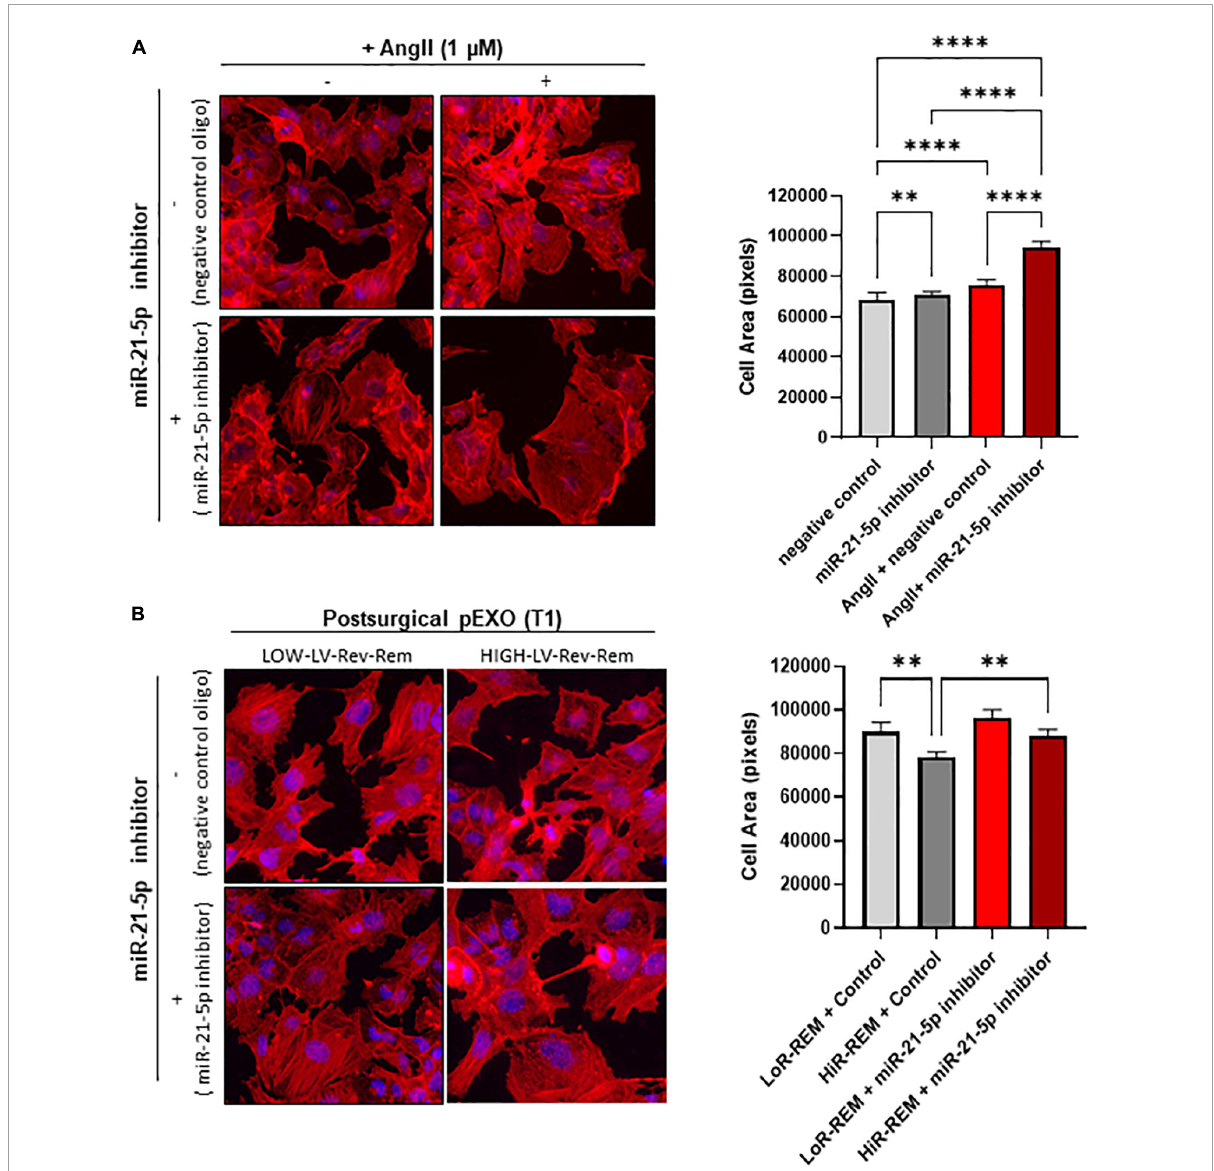
FIGURE7 Effect of miR-21-5p inhibition on cardiomyocytes size. The HL-1 cells were seeded at a concentration of 5,000 cells/cm 2 and allowed to adhere for 24 h before treatment. (A) The HL-1 cells were treated with ± 1- µ M angiotensin II (AngII, Sigma) in complete antibody-free Claycomb medium for 48 h. Moreover, 24 h after the beginning of the treatment, 30-nM miRNA-21-5p inhibitor/negative control was added to the cells using Lipofectamine R (cid:13) RNAiMAX Transfection Reagent and transfection was maintained for the following 24 h. (B) To stimulate hypertrophy, HL-1 cells were treated with 1- µ M angiotensin II (AngII, Sigma) in complete antibody-free Claycomb medium for 48 h. The pEXOs isolated at T1 from LoR-REM or HiR-REM patients were loaded with miRNA-21-5p inhibitor/negative control through a heat shock-mediated protocol, as described in the experimental procedure, then collected by ultracentrifugation. Isolated pEXOs were added at a final concentration of 1 × 10 9 particles/ml 24 h after the beginning of the AngII treatment, and treatment by pEXOs was maintained for the remaining 24 h in the presence of AngII. (A , B) At the end of each treatment, the cell monolayer was stained with Phalloidin–Atto 550 as described in the methods. The images were acquired with a fluorescence microscope (Leica; 20 × magnification); the cell areas were manually measured with ImageJ software (https://imagej.nih.gov/ij/) and expressed in pixels. Statistical significance of the differences between treatments was evaluated by one-way ANOVA. ∗∗ p < 0.01; ∗∗∗∗ p <